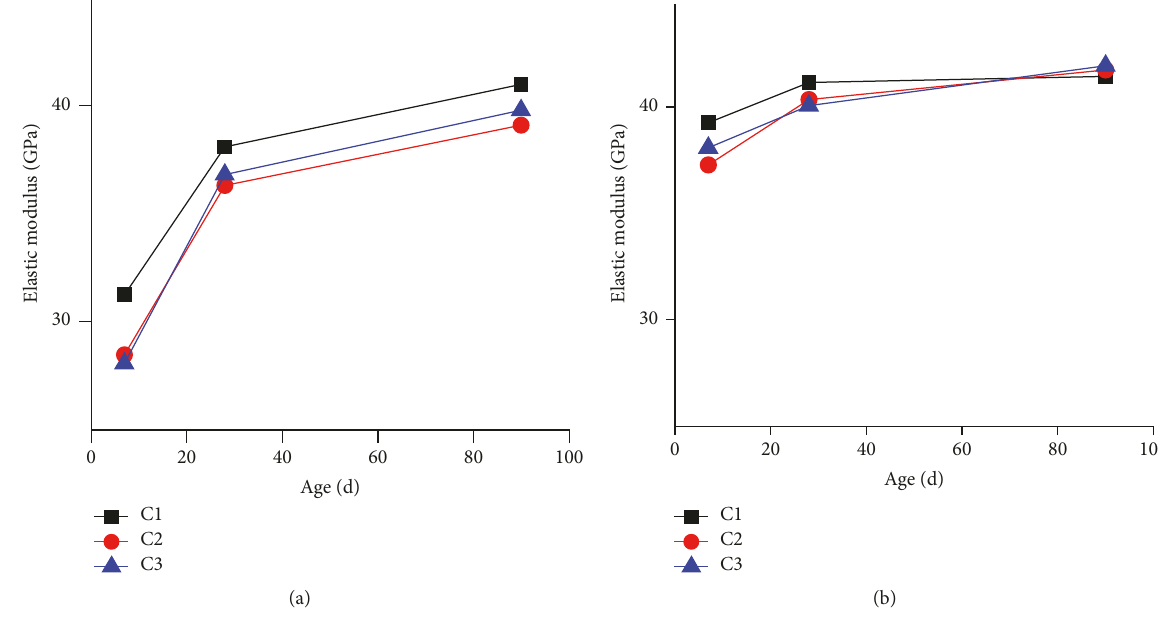
Figure 6: (a) Elastic modulus of concrete under standard curing. (b) Elastic modulus of concrete under temperature match curing.